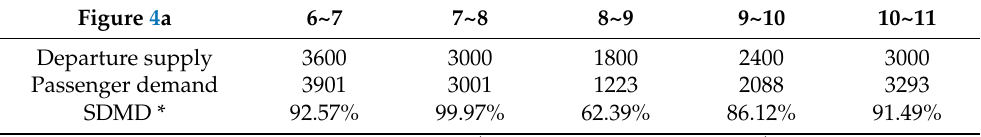
Figure 5. Supply and demand matching diagram under scenario 1. ( a ) Supply and demand matching diagram of multi-cycle train timetable. ( b ) Supply and demand matching diagram of single-cycle train timetable. Table 4. Details of supply and demand matching degree of multi-cycle timetable in scenario 1.